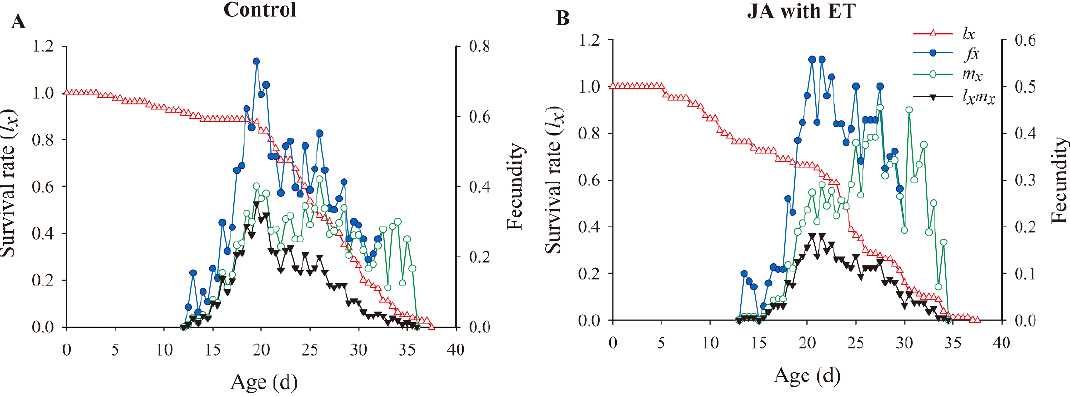
Figure 7. Effect of the JA with ET treatment on the age-specific survival rate ( l x ), age-stage-specific fecundity ( f xj ), age-specific fecundity ( m x ), and age-specific net maternity ( l x m x ) of Frankliniella occidentalis grown on faba bean plants. ( A ) Control group; ( B ) JA with ET group.